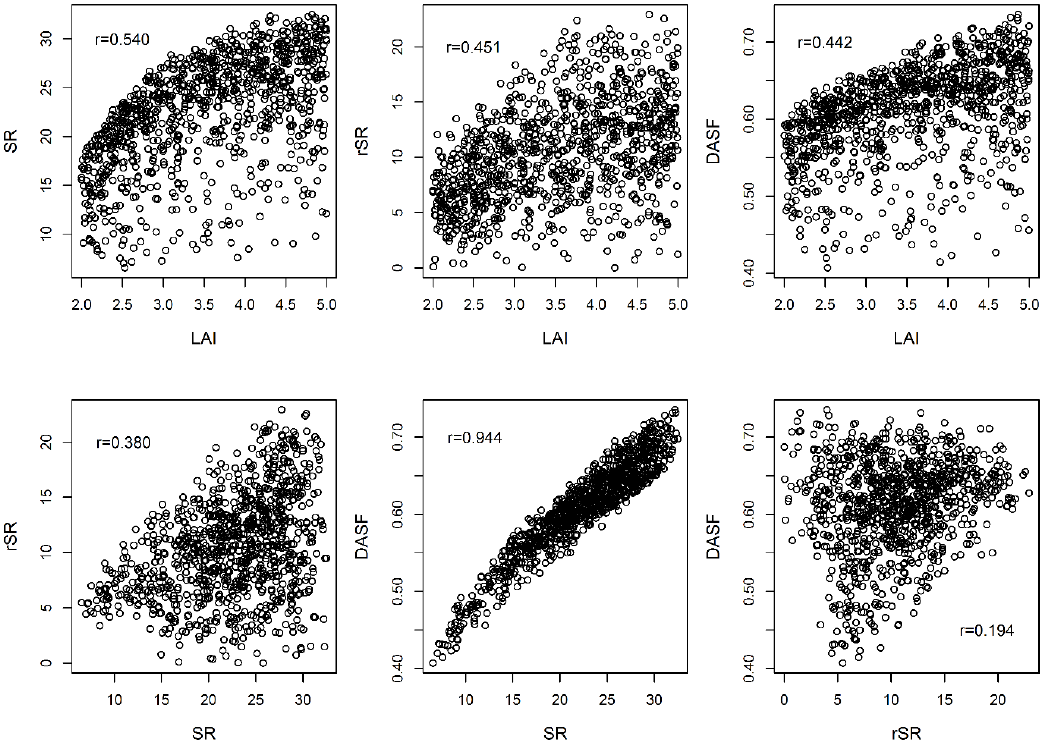
Figure 7. Scatter plots of the relationships between LAI and SR, rSR, and DASF, respectively ( top ), and relationships of the density measures ( bottom